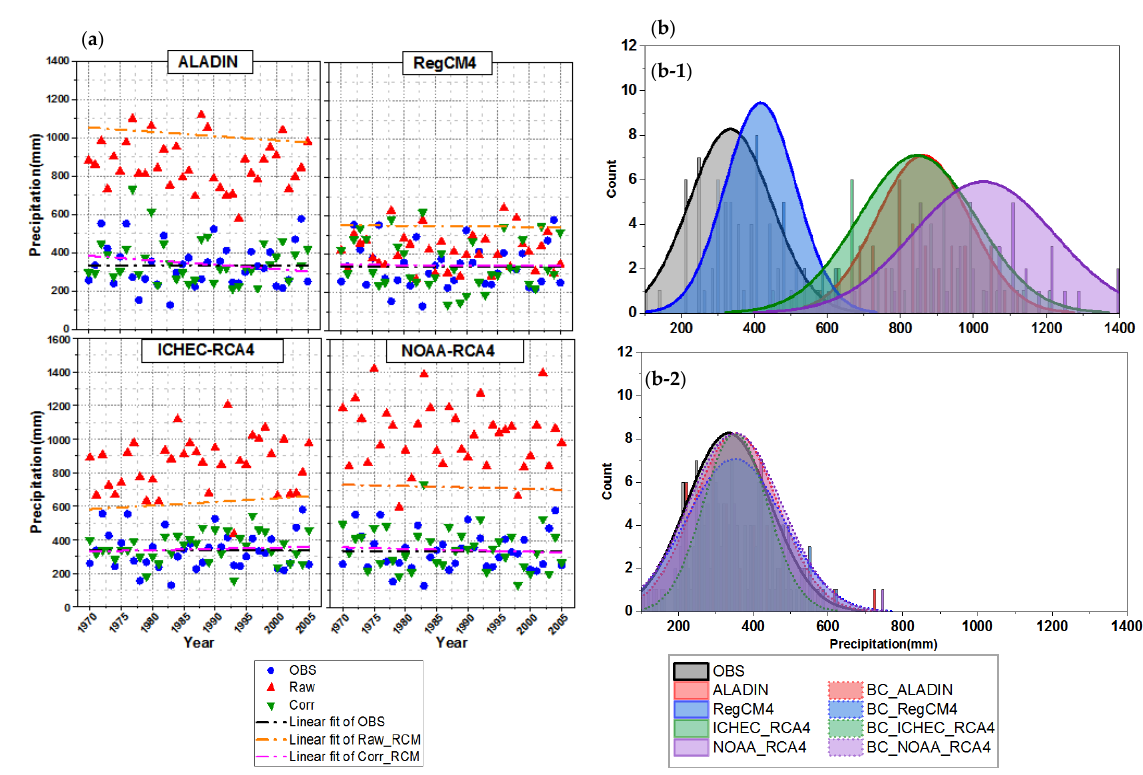
Figure 6. Areal-averaged annual precipitation for observed, raw, and adjusted (BC) RCMs for the period (1970 – 2005). ( a ) Scatter plot with fitted line; ( b ) normal distribution histograms with curves; ( b-1 ) before the bias correction, ( b-2 ) after the bias correction.